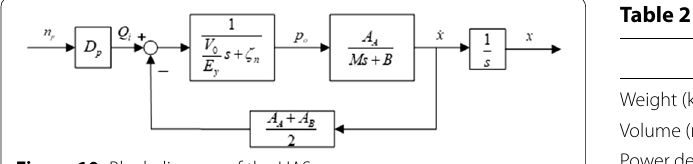
Figure 10 Block diagram of the HAS